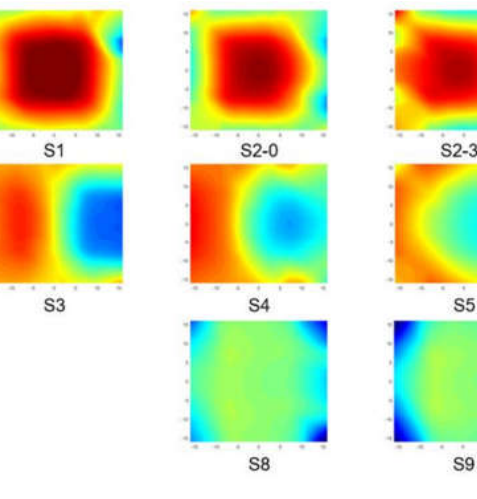
Figure 13. Temperature contour comparison among the “Outlet” conditions: ( a ) “SS”; ( b ) “PS”; ( c ) “SC”; ( d ) “PC”. 4.3. Streamwise Temperature Variation As shown in Figure 14, the average temperature of the cross-sections of the “SS”, “PS”, “SC”, and “PC” decreased as the air flows downstream. The abscissa “X/D” is the streamwise dimensionless length, where D denotes the inner diameter of the pipe. The